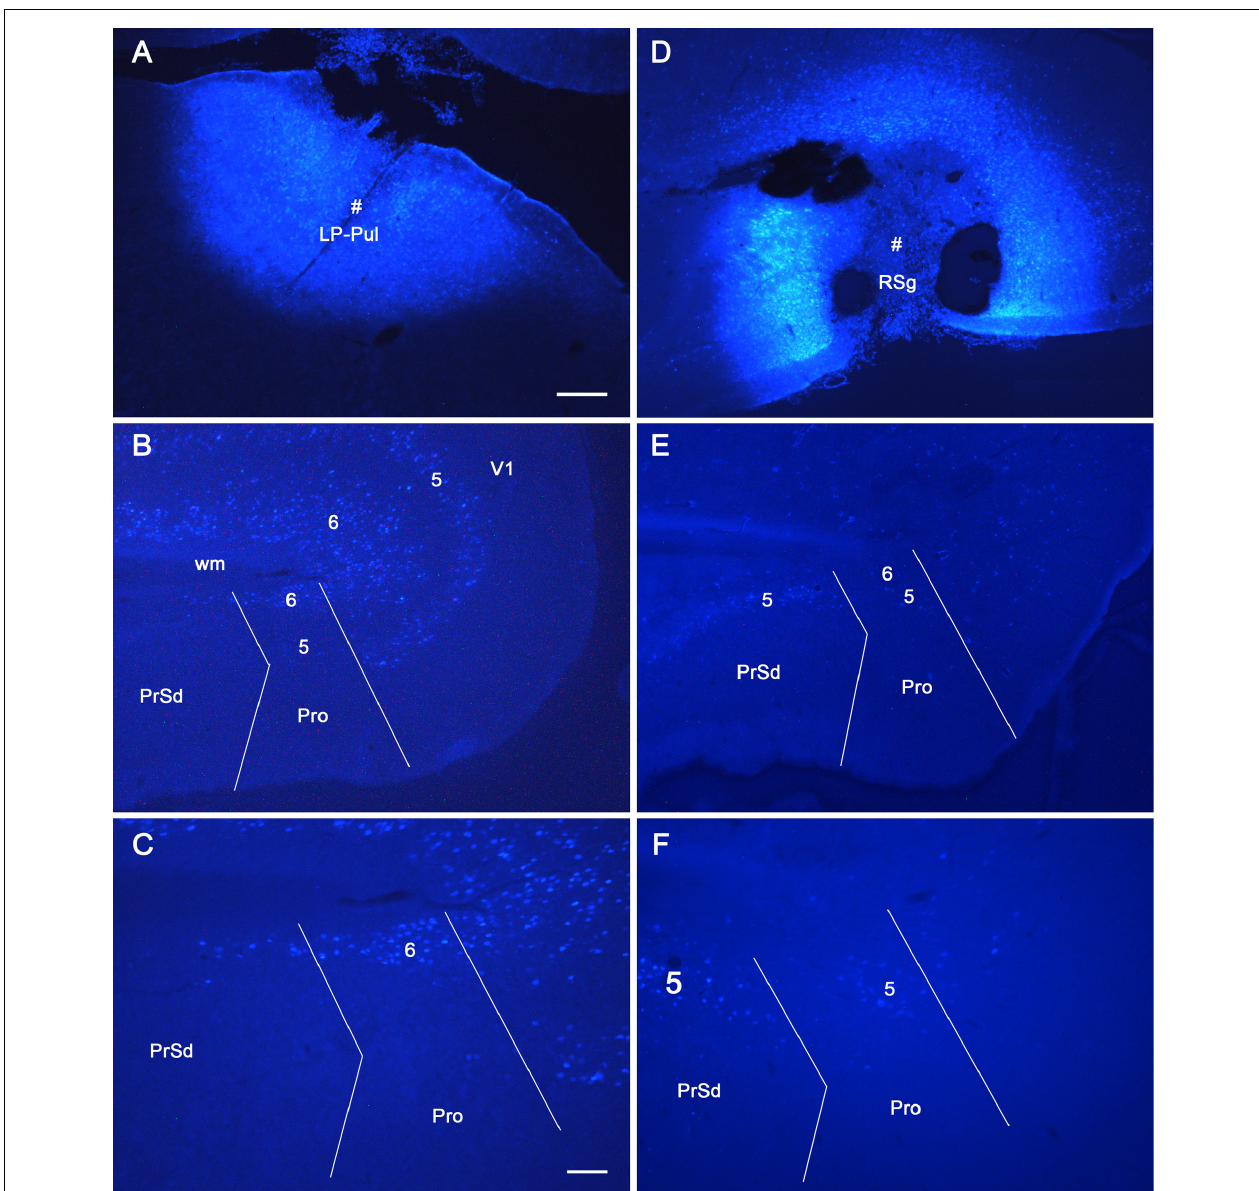
FIGURE 6 | The origins of neurons projecting from rat prostriata to LP-Pul and RSg. All panels are from sagittal sections. (A–C) The Fluoro-Gold (FG) injection in LP-Pul (# in A ) results in retrogradely labeled neurons mainly in layers 5–6 of the visual cortex (V1) and layer 6 of the prostriata (Pro in B ). Many and a few of labeled neurons are detected in layers 6 and 5 of the prostriata, respectively, as shown in the higher power view of the prostriata (C) . Note that some labeled neurons are also seen in layer 6 of PrSd (C) . (D–F) Another FG injection in the RSg (# in D ) results in some retrogradely labeled cells in layer 5 of the PrSd and prostriata (E) with higher power view in (F) . Bars: 250 µ m (A) for (A,B,D,E) ; 100 µ m (C) for (C,F)